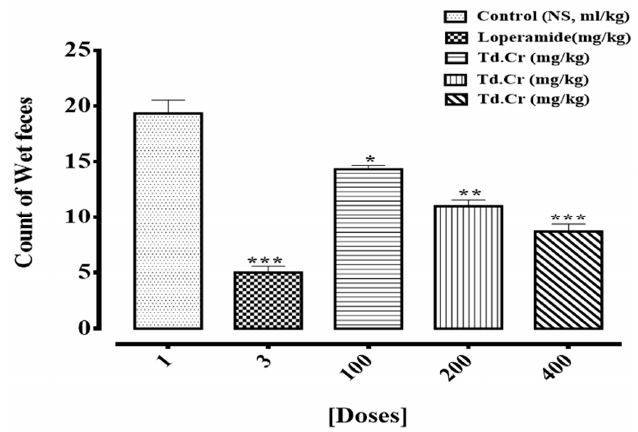
Figure 2. Bar graph representing the antidiarrheal activity of TdCr by a castor-oil-provoked method in rats. Bars express mean ± SEM with n = 6, analyzed by using ANOVA (one-way) and multiple comparison by Dunnett’s test (* p < 0.05, ** p < 0.01, *** p < 0.005 when compared to the control).